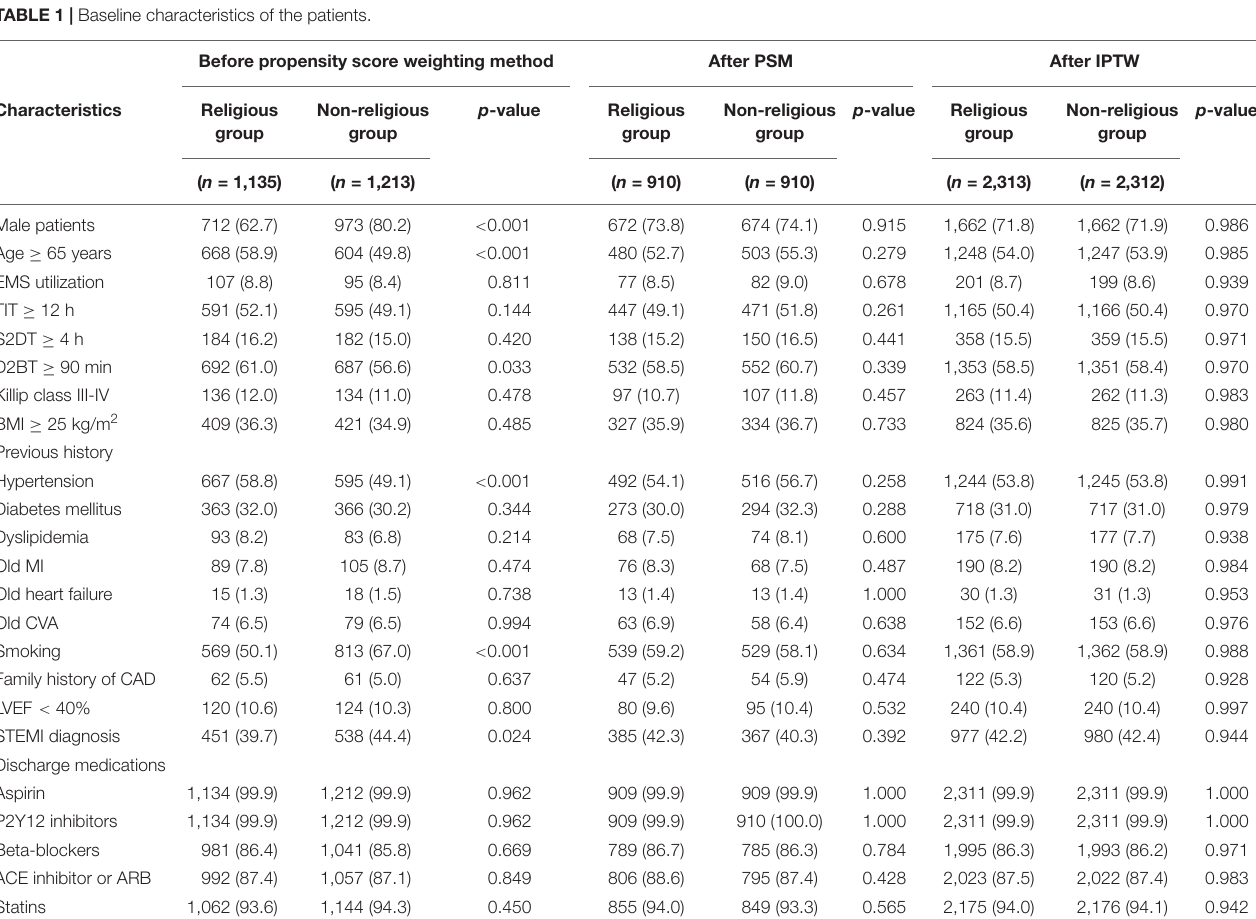
FIGURE 2 | Religious distribution of the study population. (A) AMI patients who underwent successful PCI ( n = 2,385). (B) Finally selected study patients ( n = 2,348). TABLE 1 | Baseline characteristics of the